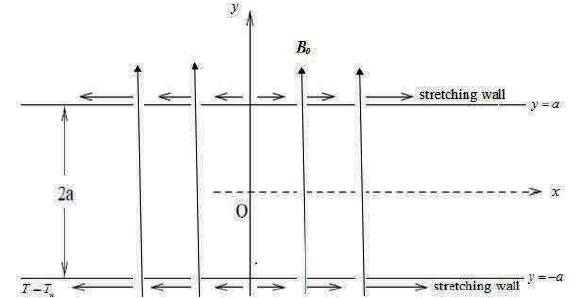
Fig. 1: Schematic diagram of flow